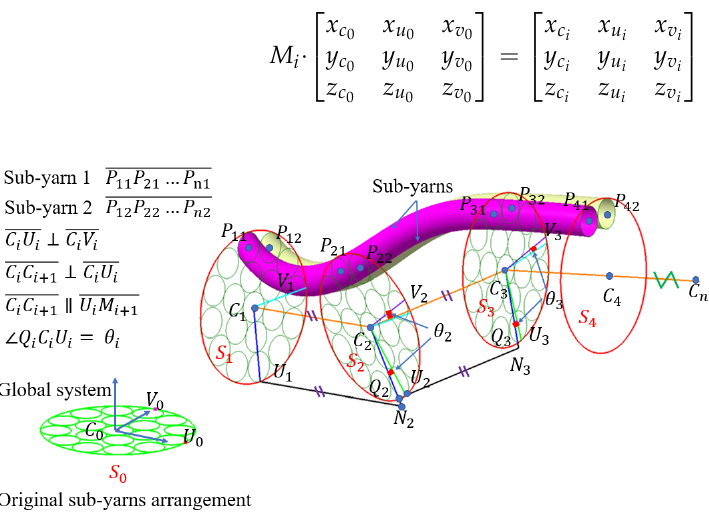
Figure 6. Illustration of the yarn discretization algorithm.